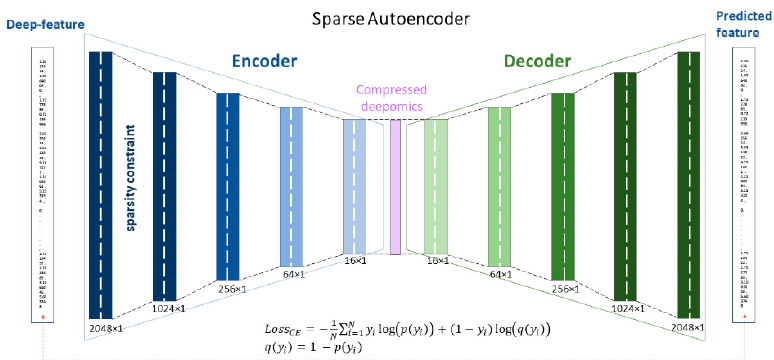
Figure 3. The proposed sparse deep autoencoder to reduce the dimensionality of the deep-thermomics is presented.